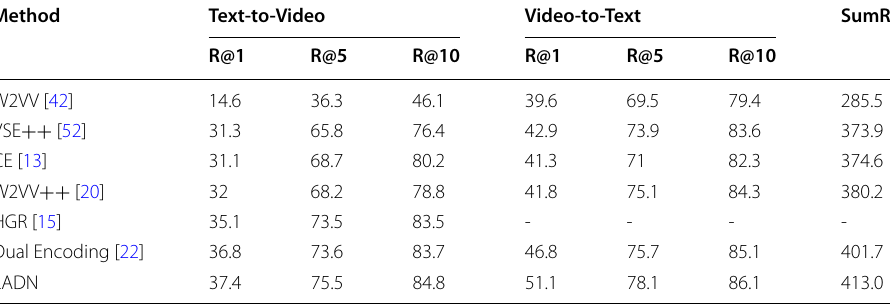
Table 3 Experimental results on VATEX